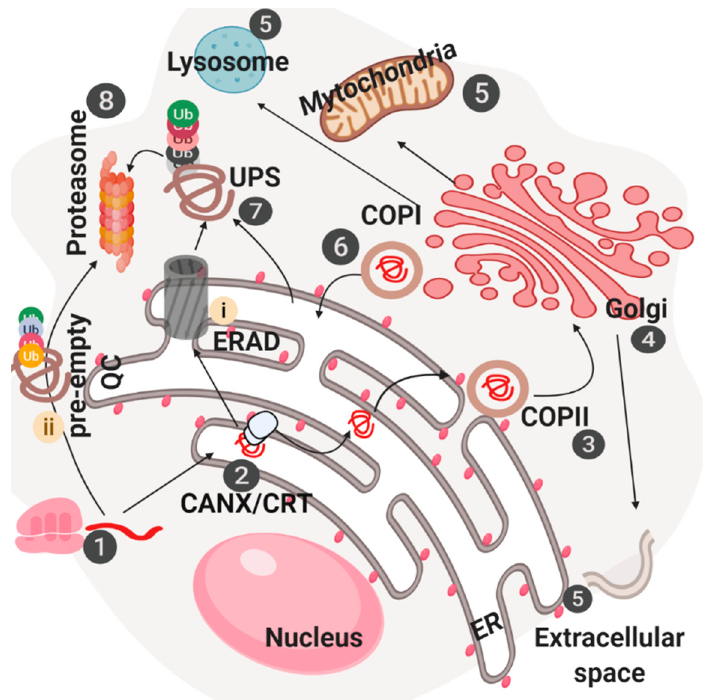
Figure 1. Molecular machines involved in the control of protein homeostasis in the early secretory pathway. After ribosomal-dependent messenger RNA (mRNA) translation ( 1 ), newly synthesized polypeptide chains are imported in the endoplasmic reticulum (ER) lumen. Here, proteins encounter diverse chaperones, modifying enzymes and complexes, such as CANX/CRT, necessary for maturation and folding ( 2 ). Once ready, mature proteins are embedded into COPII vesicles ( 3 ) and transported into the Golgi compartment ( 4 ). Here other chaperones and enzymes complete proteins maturation. Finally, once completely ready proteins are translocated in diverse subcellular compartments (extracellular space, mitochondria, lysosomes, etc.) ( 5 ). In the other hand, COPI vesicles mediate Golgi-to-ER retrograde transport of immature proteins ( 6 ). Proteins that are not fully mature and do